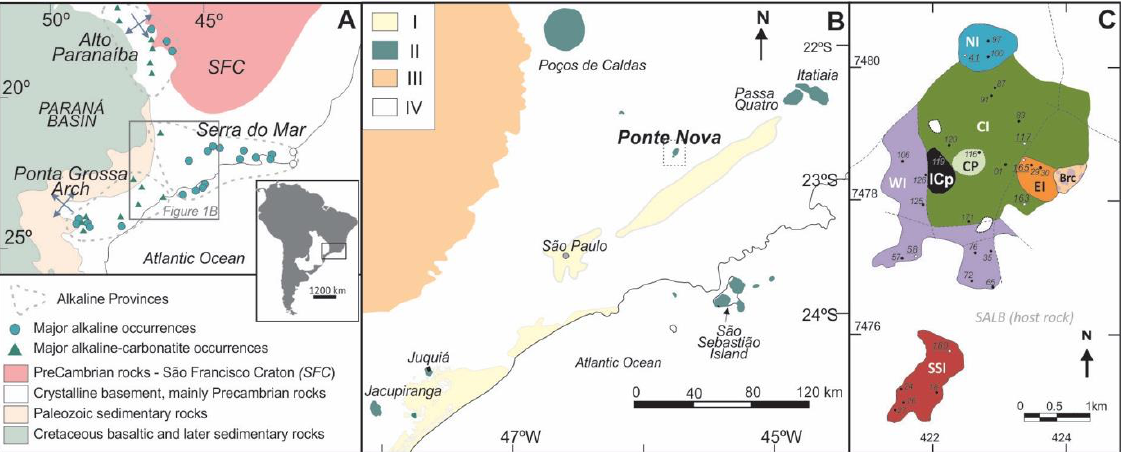
Figure 1. ( A ) Geological setting of the alkaline intrusions of Cretaceous magmatism in the southeastern part of Brazilian Platform, with the distribution of major alkaline occurrences of Alto Paranaíba, Serra do Mar and Ponta Grossa Arch alkaline provinces (Modified after [45]). ( B ) Detail of A, with the location of the main occurrences. Legend: I. Sediments or sedimentary rocks associated with rift basins (Cenozoic); II: Alkaline complexes (Meso-Cenozoic); III: Sedimentary rocks of the Paraná Basin (Ordovician-Silurian); IV: Crystalline Basement, Brasília and Ribeira orogenic belts (Precambrian). Simplified from [45]. ( C ) Simplified geological map of the Ponte Nova alkaline mafic – ultramafic massif [41]. Utilized abbreviations: CI, central intrusion; WI, western intrusion; NI, northern intrusion; EI, eastern intrusion; CP, central plug; SSI, southern satellite intrusion; ICp, ilmenite clinopyroxenites and magnetitites; Brc, magmatic breccia; SALB: Serra de Á gua Limpa Batholith. Locations of studied samples are indicated as dots on the map; numbers in italic refer to samples analyzed by electron microprobe — wavelength dispersion system (EMP-WDS) and numbers in italic and underlined were analyzed by EMP-WDS and laser ablation — inductive coupled plasma mass spectrometry (LA ICP-MS).